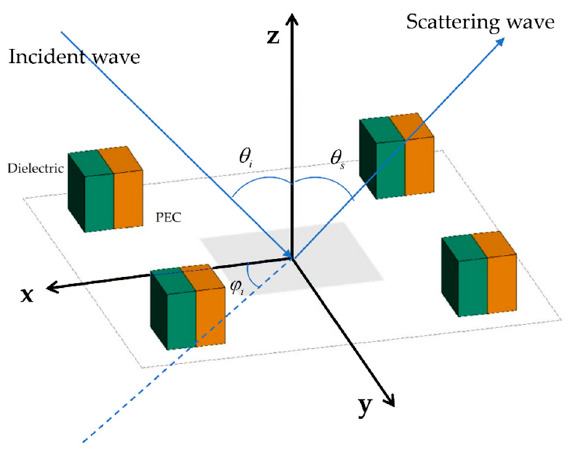
Figure 3. The location of four hybrid dielectric and conductor cubes in free space.